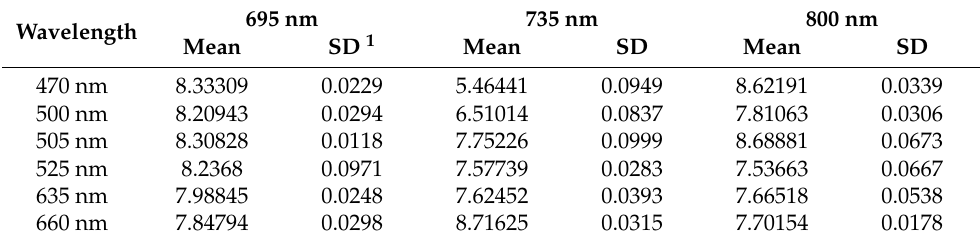
Figure 12. Differences of visible spectrum image at 695 ( a ), 735 ( b ), and 800 nm ( c ) wavelength by 470, 500, 525, 635, 660 nm. Table 3. PSNR values at different wavelengths.